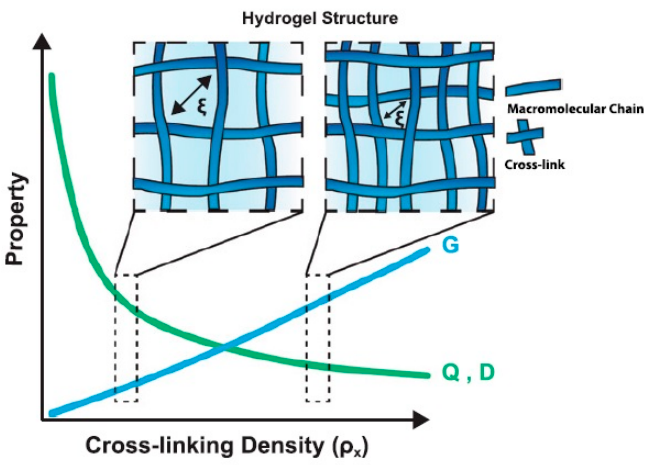
Figure 2. Relationship between the cross-linking density and HG properties. Two network structures representative of low and high cross-linking densities are depicted to demonstrate the relationship between the cross-linking density and basic HG properties of highly swollen, non-ionic gels, including shear modulus ( G ), equilibrium volumetric swelling ratio ( Q ) and diffusivity ( D ). As the cross-linking density increases, the mesh size ( ξ ) decreases, which is a measure of the space available between macromolecular chains for the diffusion. Reprinted with permission from Ref. [5].